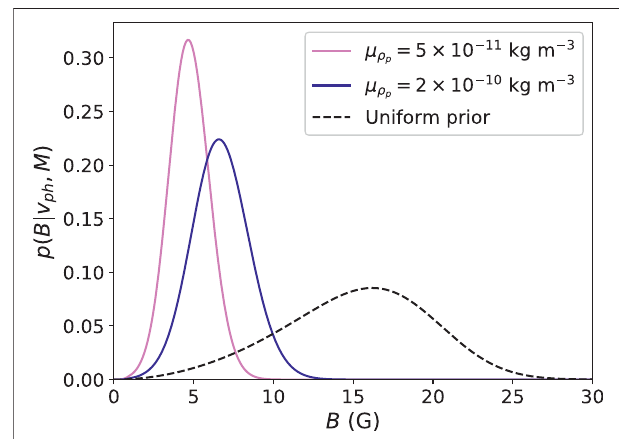
FIGURE 5 | Posterior distributions of the magnetic fi eld strength ( B ) in a fully fi lled magnetic thread considering a Gaussian prior for the internal density (cid:2) 5 × 10 − 11 kg m − 3 (pink), a Gaussian prior with mean ( ρ i ) with mean μ ρ p μ ρ (cid:2) 2 × 10 − 10 kg m − 3 (blue), and a uniform prior (black dashed line). p Uncertainties in Gaussian priors are considered to be of 50%. From Montes- Solís and Arregui